Question: Draft a figure caption describing what is shown.
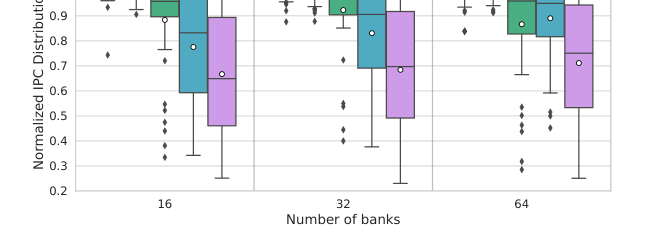
Answer: Normalized performance (distribution) of single- core applications with varying numbers of DRAM banks in the system for ABACuS and four state-of-the-art mechanisms (NRH = 125).